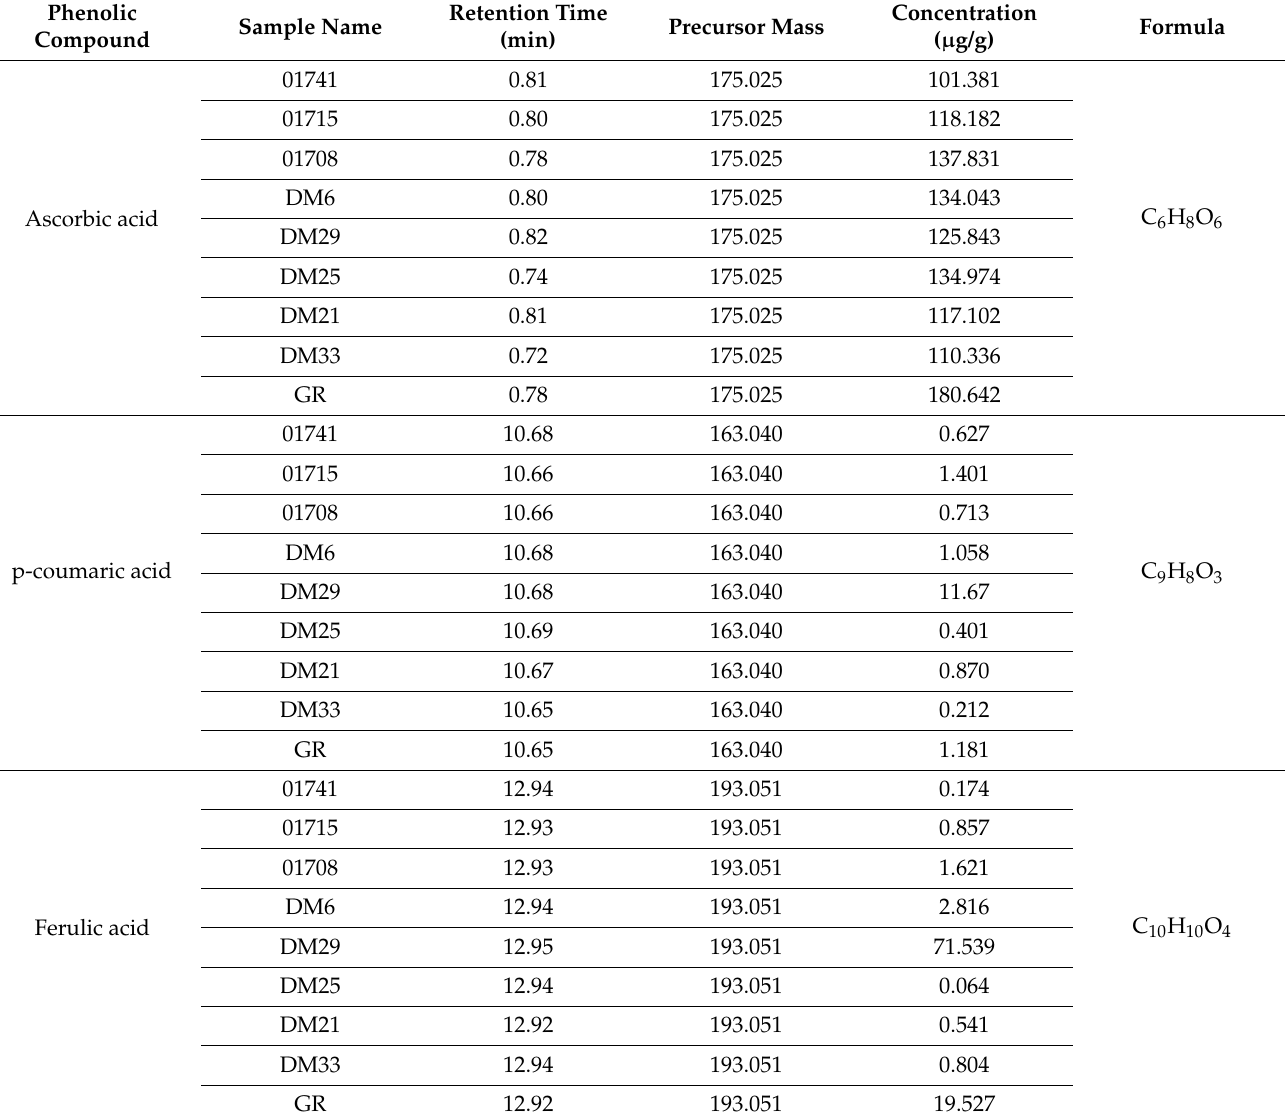
Table 2. Quantification of phenolic compounds identified in nine tested rice varieties (01708,